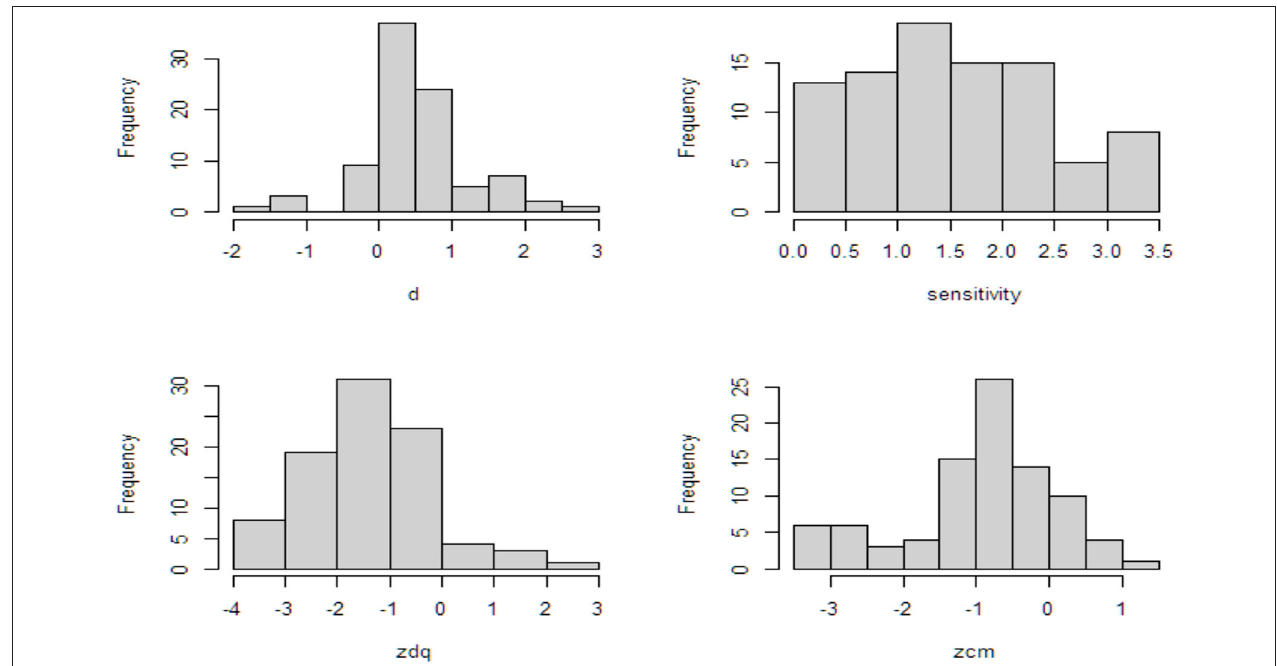
FIGURE 5 | Histograms of d , sensitivity, and the z-scores for the DQ and CM prevalence estimates (after imputation of the infinite scores by − 3.5).